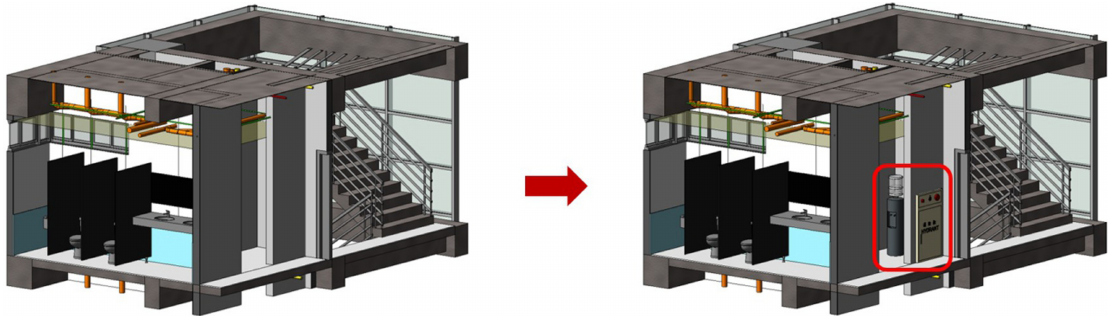
Figure 4. Updated As-Built BIM model for FM in the case study.